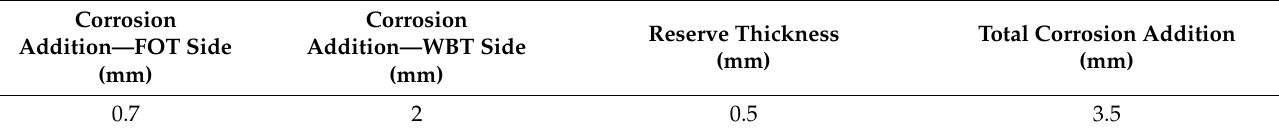
Table 1. Corrosion additions for the LG plating of bulk carriers according to IACS